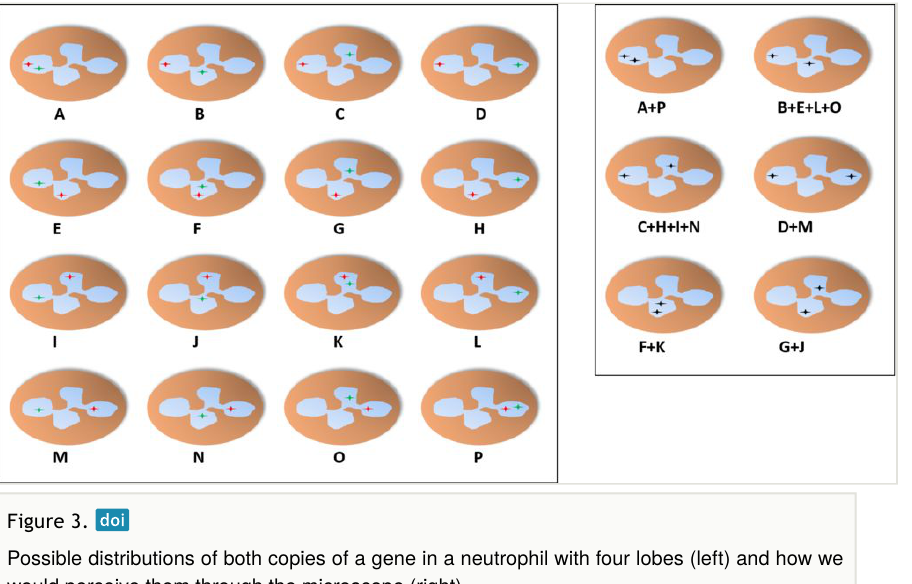
Figure 3. Possible distributions of both copies of a gene in a neutrophil with four lobes (left) and how we would perceive them through the microscope (right).